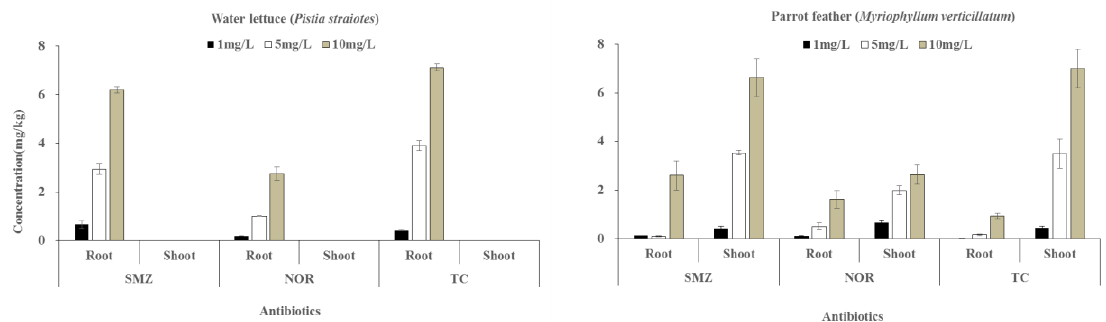
Figure 5. Selected antibiotic concentrations (on a dry weight basis) in water lettuce and parrot feather plants under various treatments at the end of the experimental period. Values are the mean ± S.D. of three parallel individuals in each container.